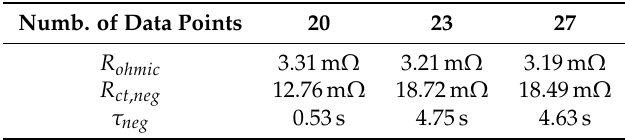
Table A1. The fitting results for R ohmic , R ct , neg , and τ neg are presented. These correspond to the number of fitted data points presented in Figure